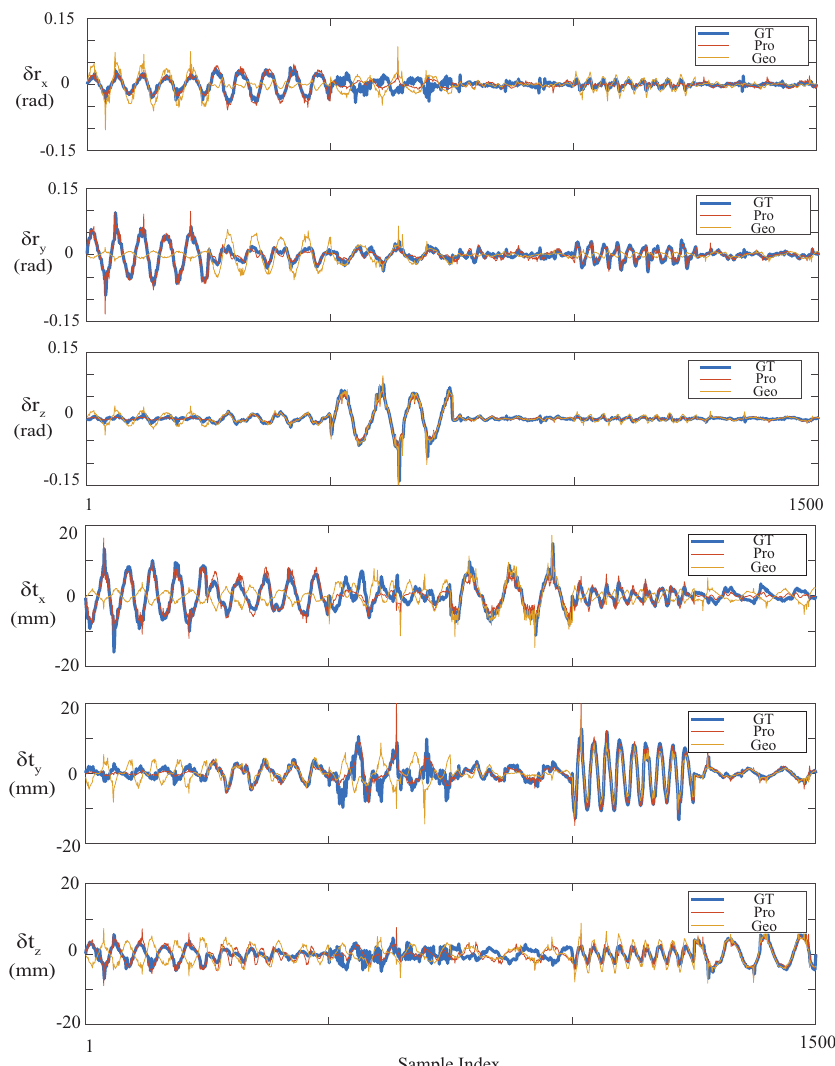
Figure 5. Motion reconstruction results of the test set. Specifically, this figure includes the rotational components (top three subfigures) and translational components (bottom three subfigures) of the interframe motion increments in the test set. It was confirmed that the proposed method obviously outperforms the geometric-only